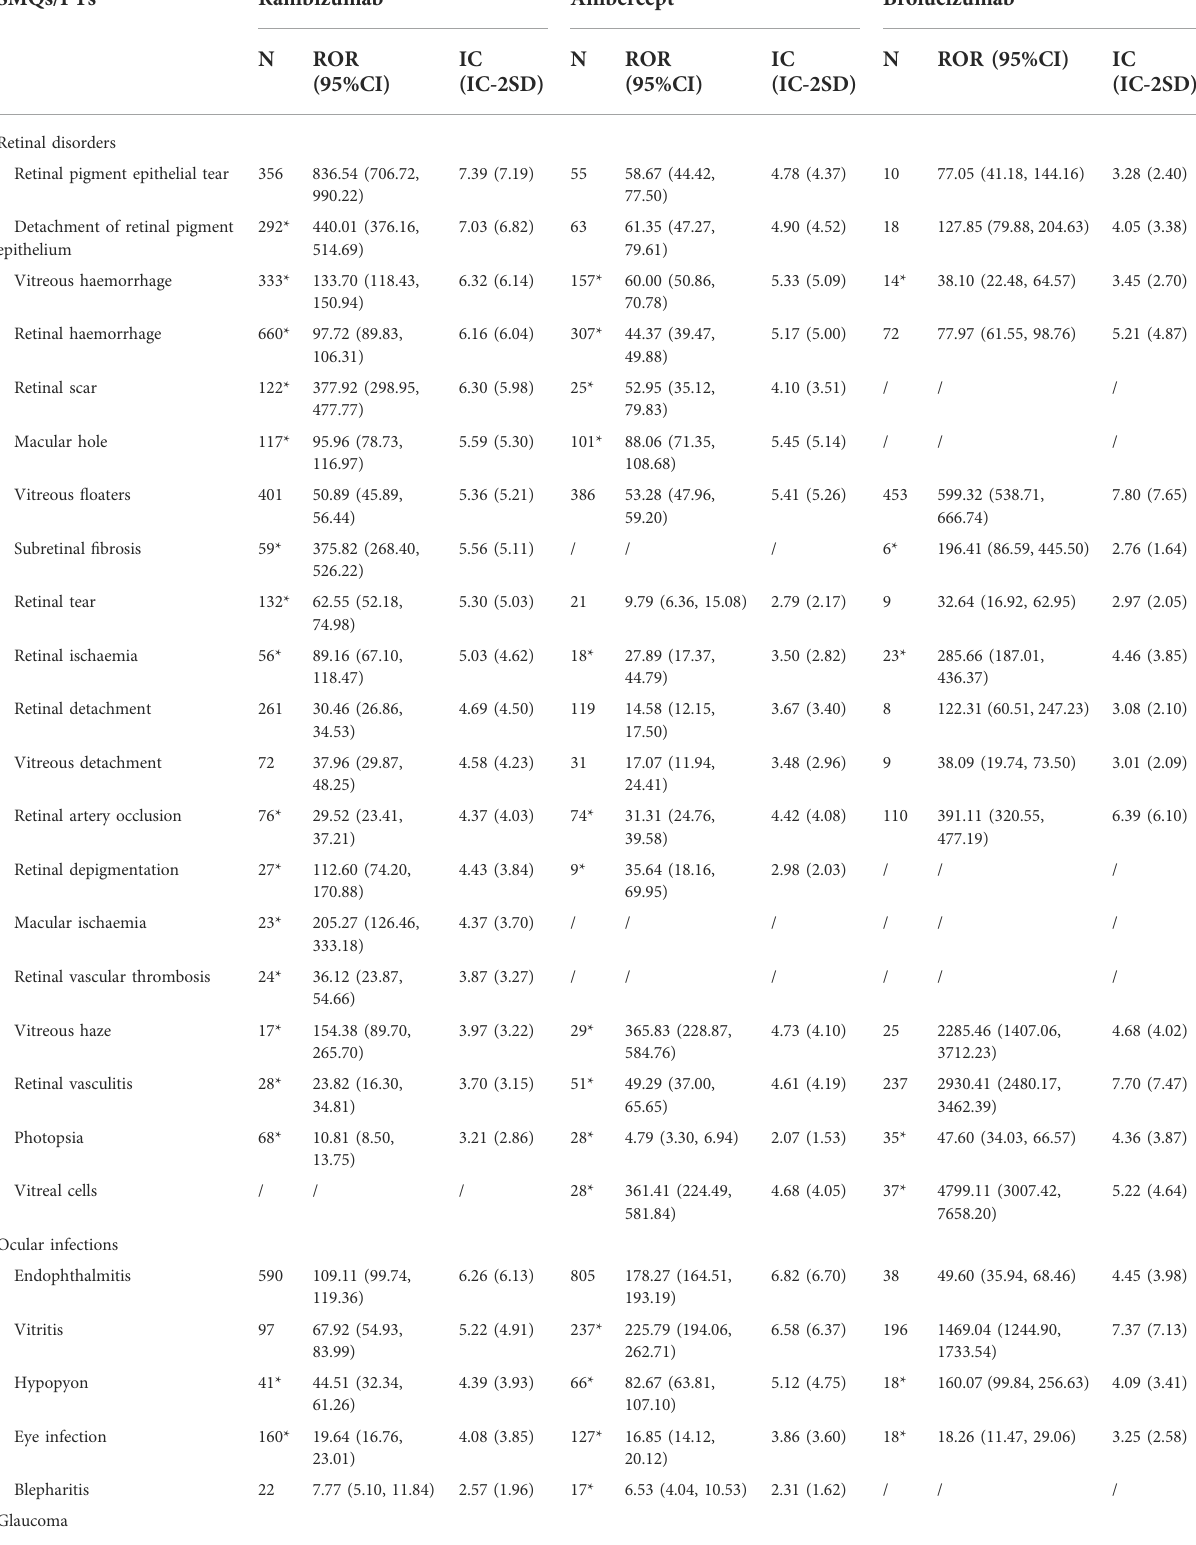
TABLE 4 Moderate and strong signals of anti-VEGF drugs in ocular adverse events.